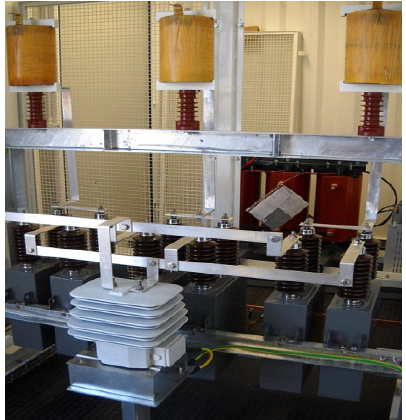
Figure 24. Specialized passive filter.